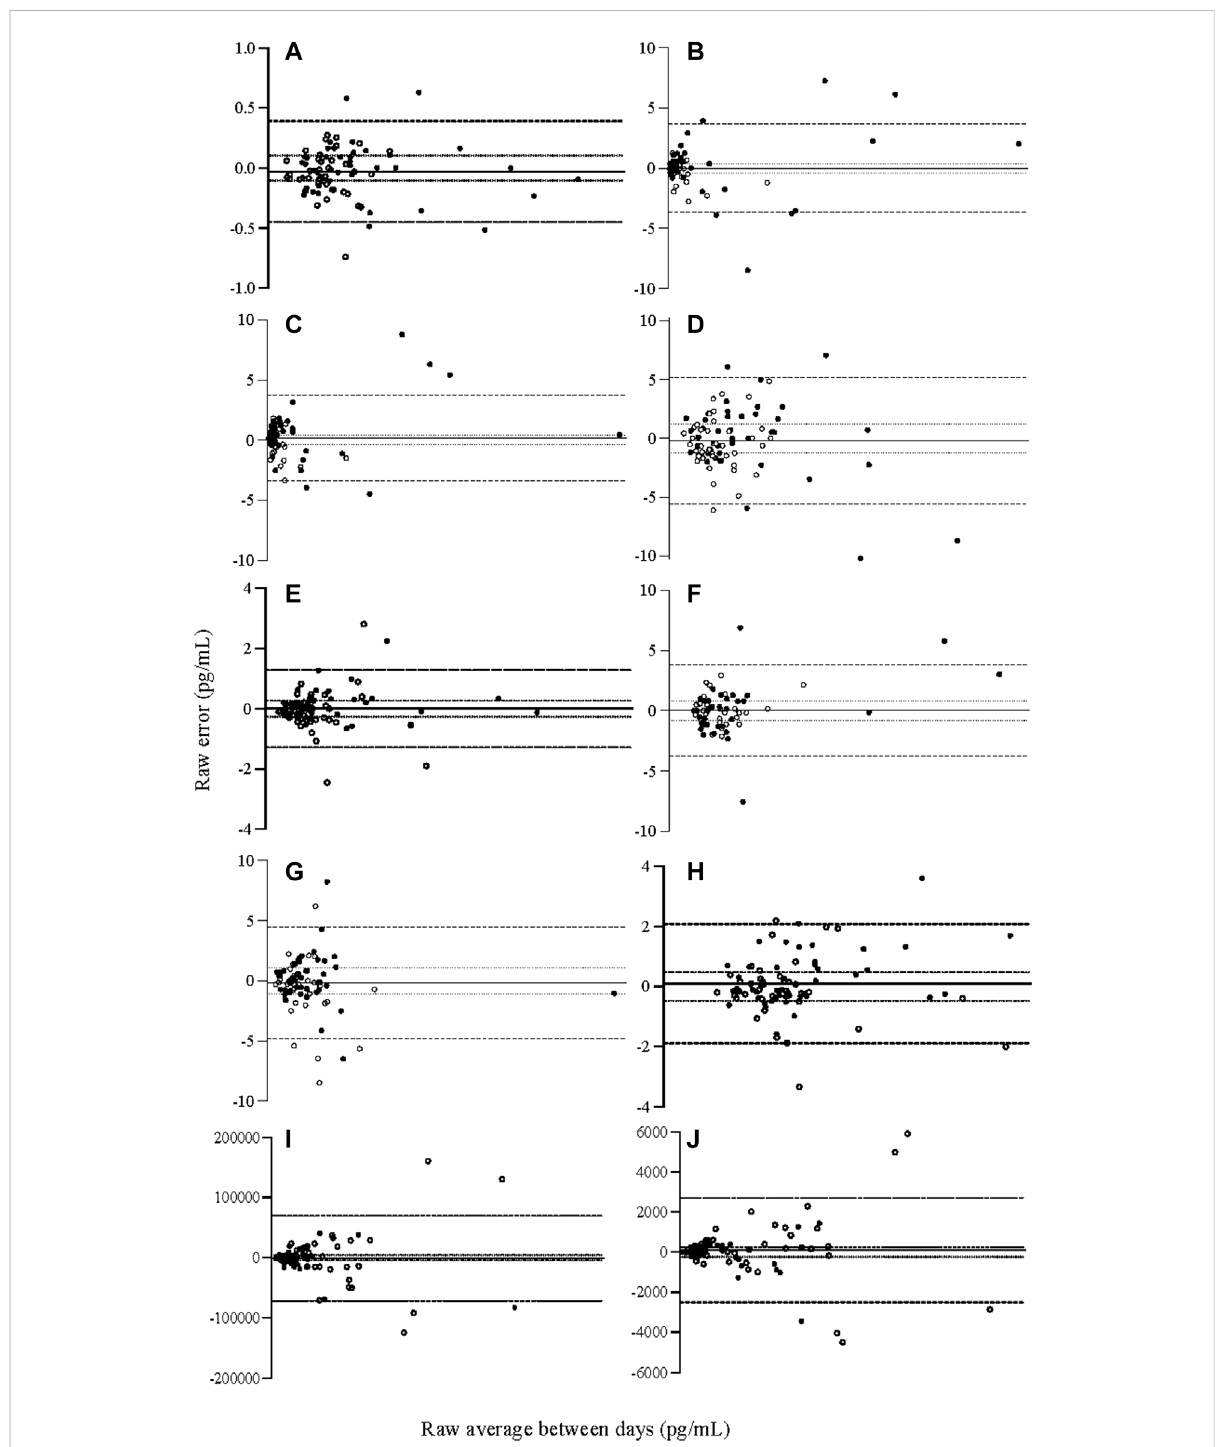
FIGURE 1 Relative Bland and Altman plots displaying raw between-day (total) error for cytokine analyte concentrations (A) IL-1 β (B) IL-6 (C) IL-8 (D) IL-10 (E) IL-12, (F) IL-15, (G) IFN- ƴ , (H) TNF- α , (I) adiponectin, (J) leptin. Biascalculatedasaverageerror,95%limitsofagreementastwoSDfromthelineof bias, acceptable error of 15% calcualted per analyte, established a priori . N = 84. IFN- γ : interferon gamma, IL: interleukin, TNF- α : tumour necrosis factor alpha. ── Bias, 95% limits of agreement, acceptable error, C males, ○ females